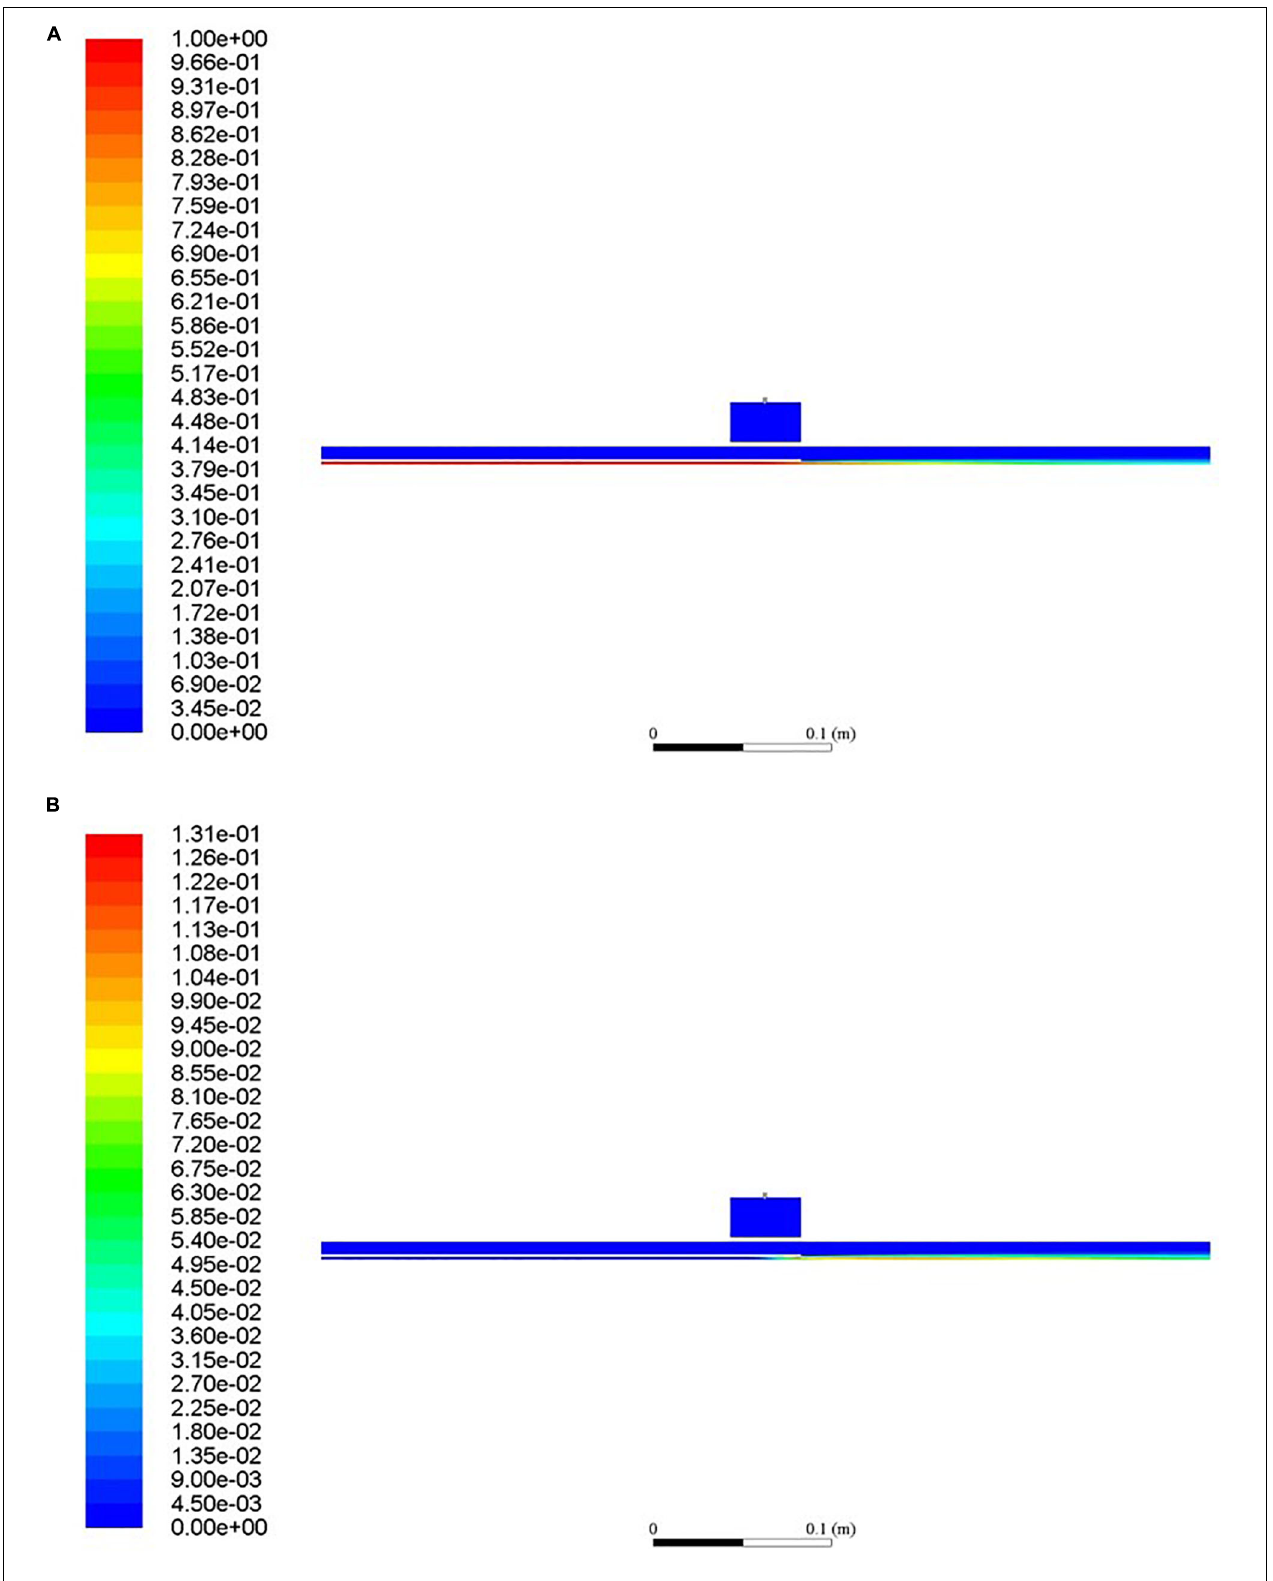
FIGURE 6 | CH 4 (A) and C (B) mass fraction for the dual tube configuration (270 mm).